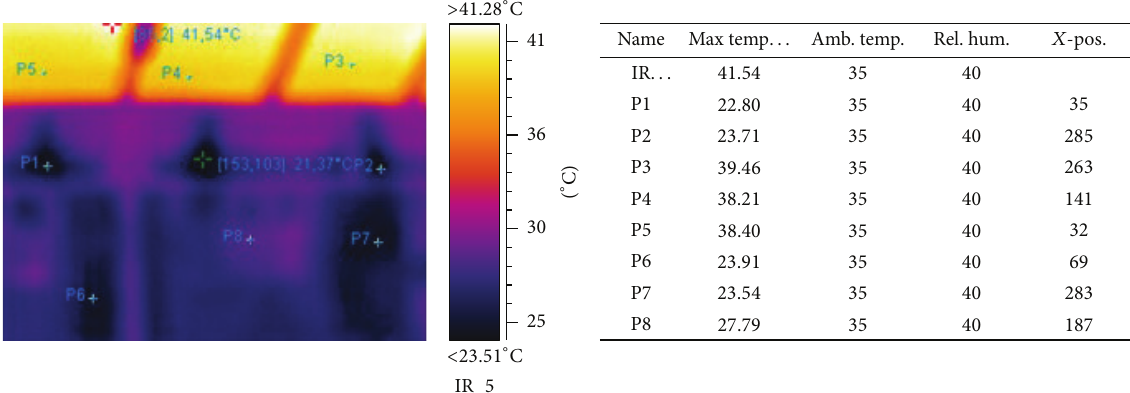
Figure 8: The thermal camera images and information of the arbor subregion, three nozzles.